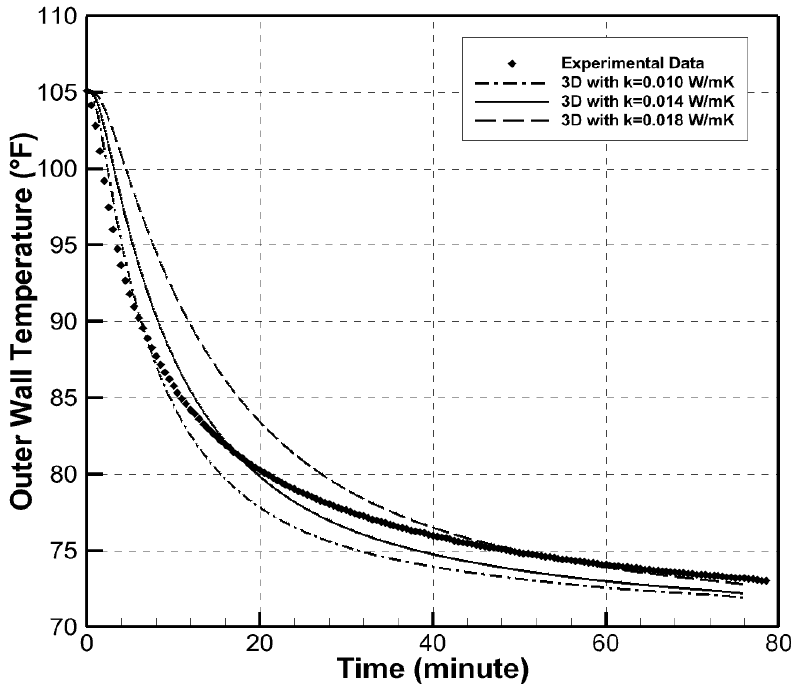
Figure 6. Comparison of simulation results to experimental results of Spaceloft ® aerogel wall material.